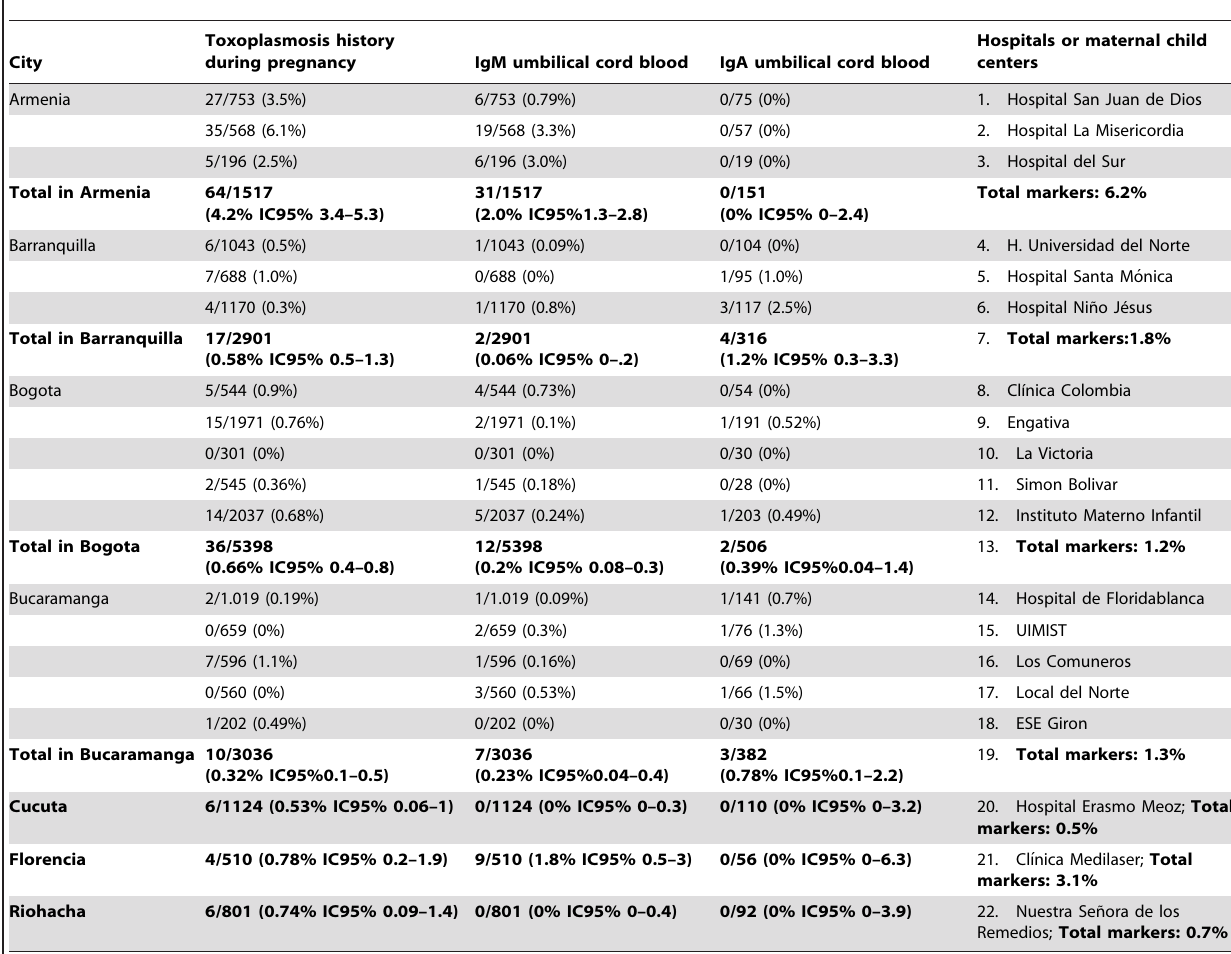
Table 2. Frequency of markers for congenital toxoplasmosis in hospitals and maternal child care centers in 7 cities.